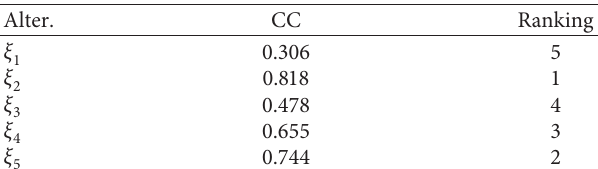
Table 21: Relative closeness coefficient and ranking of each alternative. Alter.